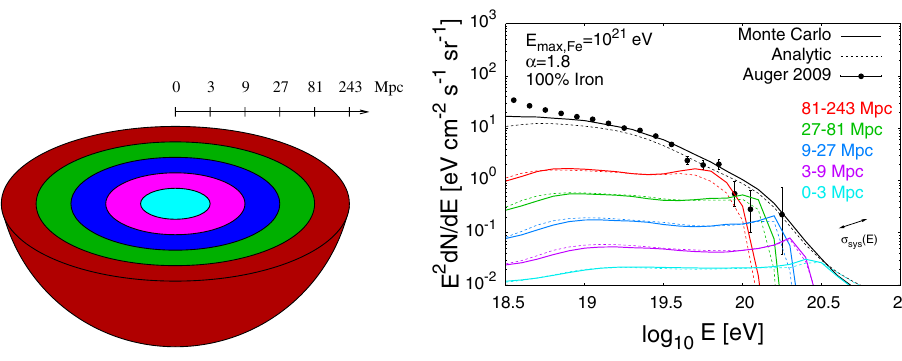
Figure 2. Left-panel : a depiction of the source shells considered. Right panel : a spectral plot showing PAO measurements, Monte Carlo and analytic derived fluxes arriving from the different source shells. The functional form of the analytic expression describing the spatial distribution of species A